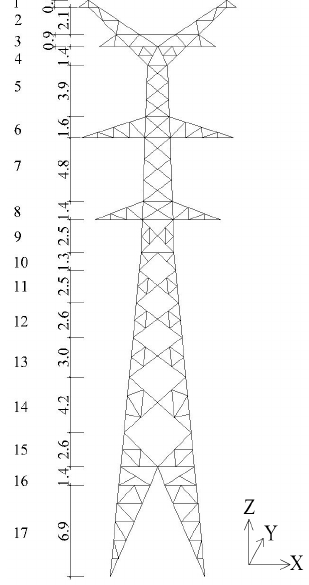
Figure 22. Segments of prototype structure.